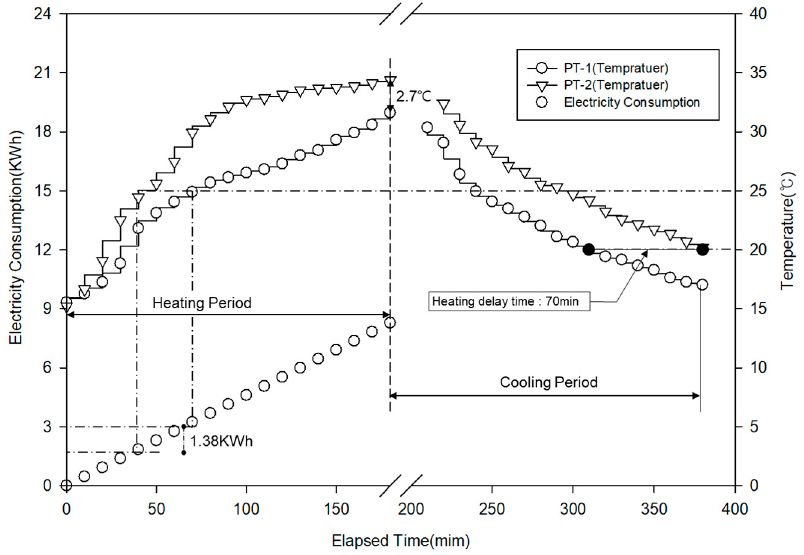
Figure 15. Change of temperature and electric consumption.